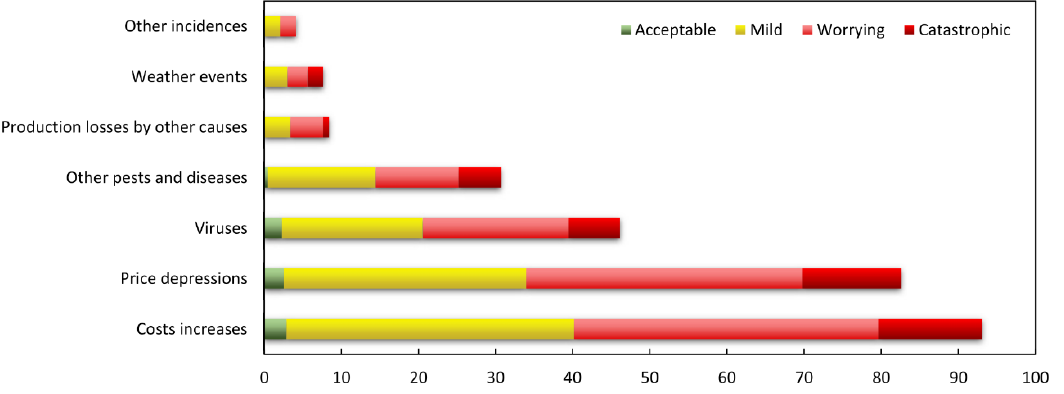
Figure 1. Concerns of Spanish vegetable greenhouse growers according to a survey in Almeria province (elaborated with data from Consejería de Agricultura y Pesca. Junta de Andalucía, 2009) [3].